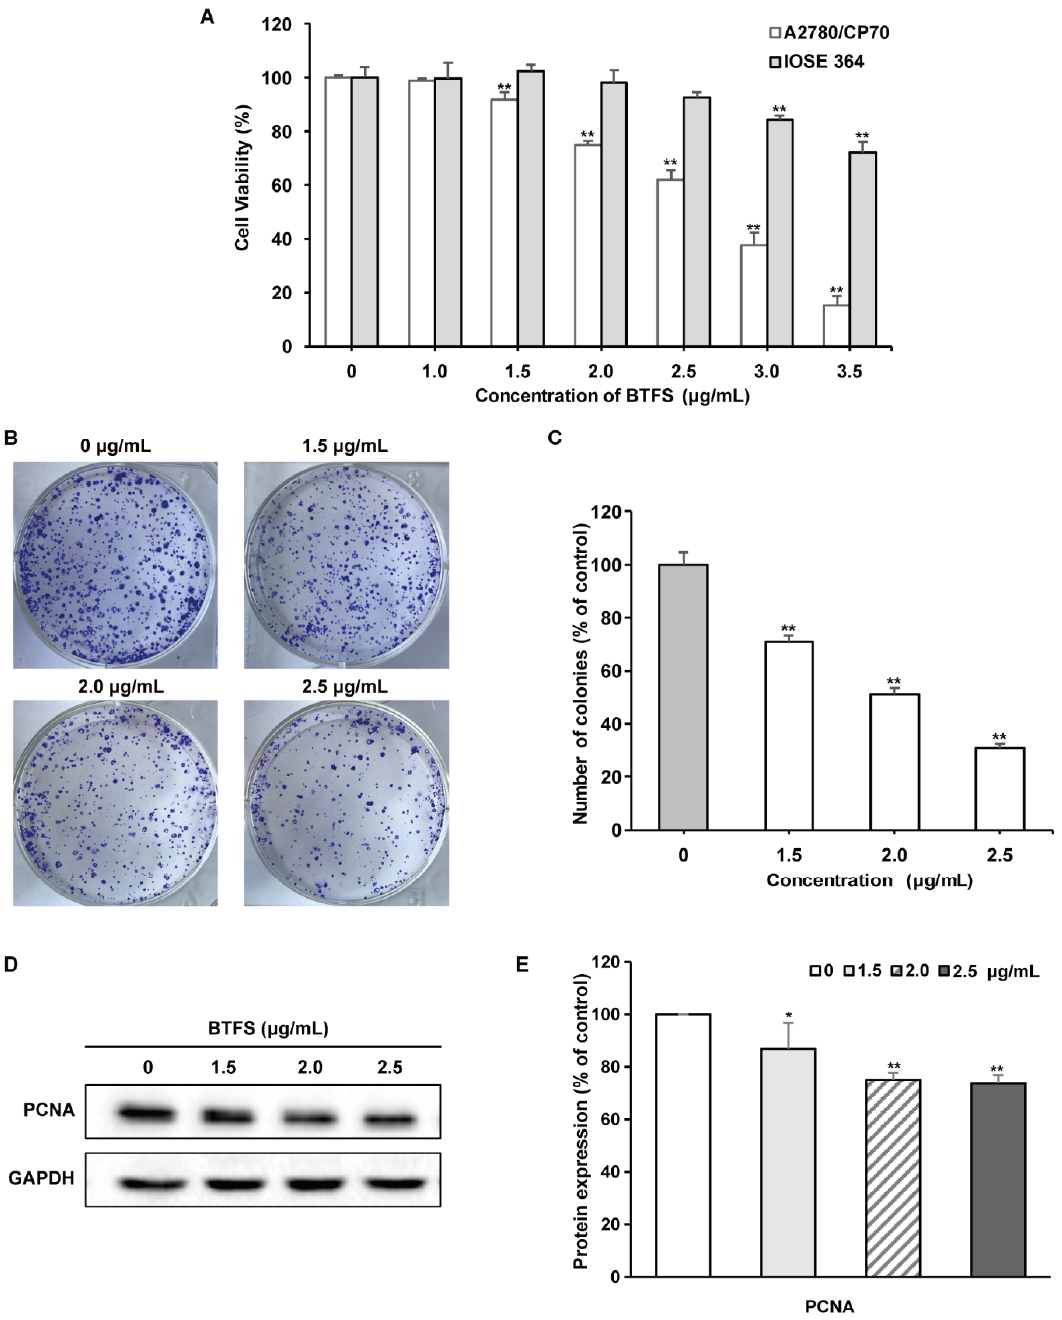
Figure 2. BTFS inhibits proliferation of A2780/CP70 cells. ( A ) BTFS inhibited the cell viability of A2780/CP70 and showed moderate effect on IOSE-364 cells. ( B ) The effect of BTFS on colony formation of A2780/CP70 cells. ( C ) Statistical histogram. * p < 0.05; ** p < 0.01 versus control. ( D )Effects of BTFS on protein expression of PNCA in A2780/CP70 cells. ( E ) Statistical histogram of protein quantization. * p < 0.05; ** p < 0.01 versus control.